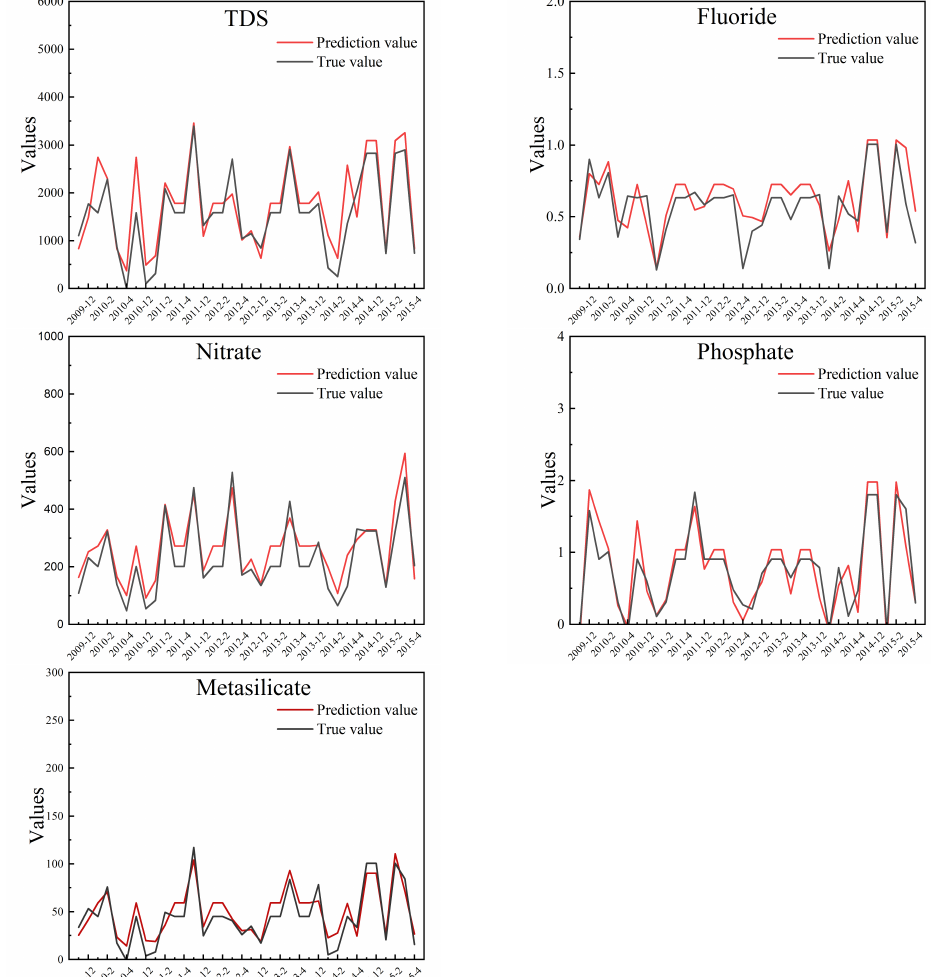
Figure 5. Prediction values and true values for the five indicator concentrations in the dry